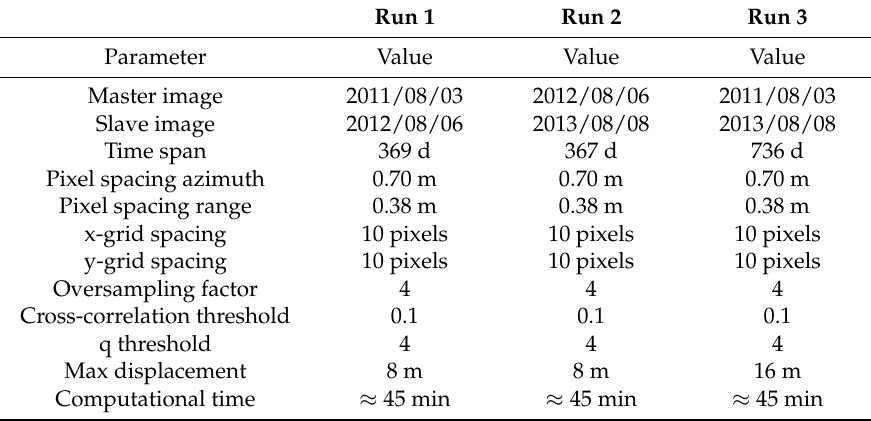
Figure 3. Slumgullion landslide displacement rate, in meters per year, for the time frame August 2011–August 2012. The superimposed arrows represent the direction of the estimated vector field. Table 1. Summary of the adopted Sub-Pixel Offset Tracking (SPOT) parameters.